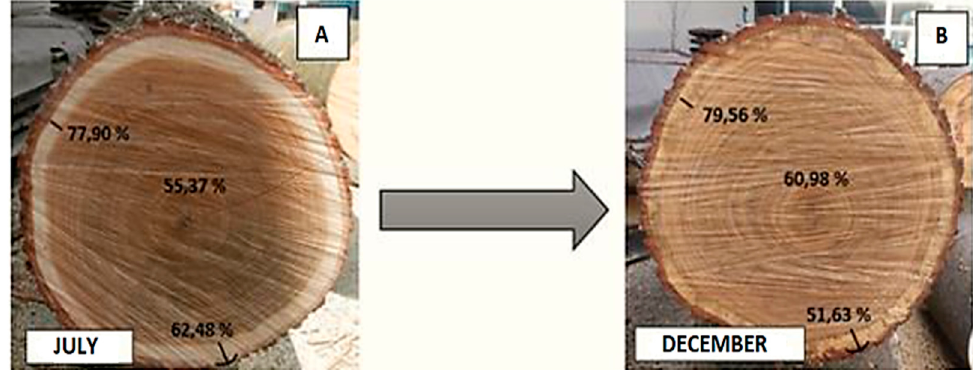
Figure 7. The moisture distribution ( A ) at the beginning of storing and ( B ) after six months of storing the oak logs. The overall trend of the shear strength during the six months of storage usually had a decreasing tendency. Similar findings were discovered in the studies [8,9]. The relationship between the bark moisture content and the values of the shear strength was also similar for beech wood (Figure 8B). As the moisture content of the bark increased, the strength decreased. However, in oak, the changes in the moisture content of bark became evident in November and December, leading to the assumption that oak with a thicker bark tolerated the moisture changes better than beech with a thinner bark. Overall, we can confirm that the bark moisture content is proving to be one of the most important factors affecting the shear strength of the bark/wood interface. Based on the research [1,4,5,7,8], the dependence of the shear strength on the value of the bark moisture content for other can be confirmed.